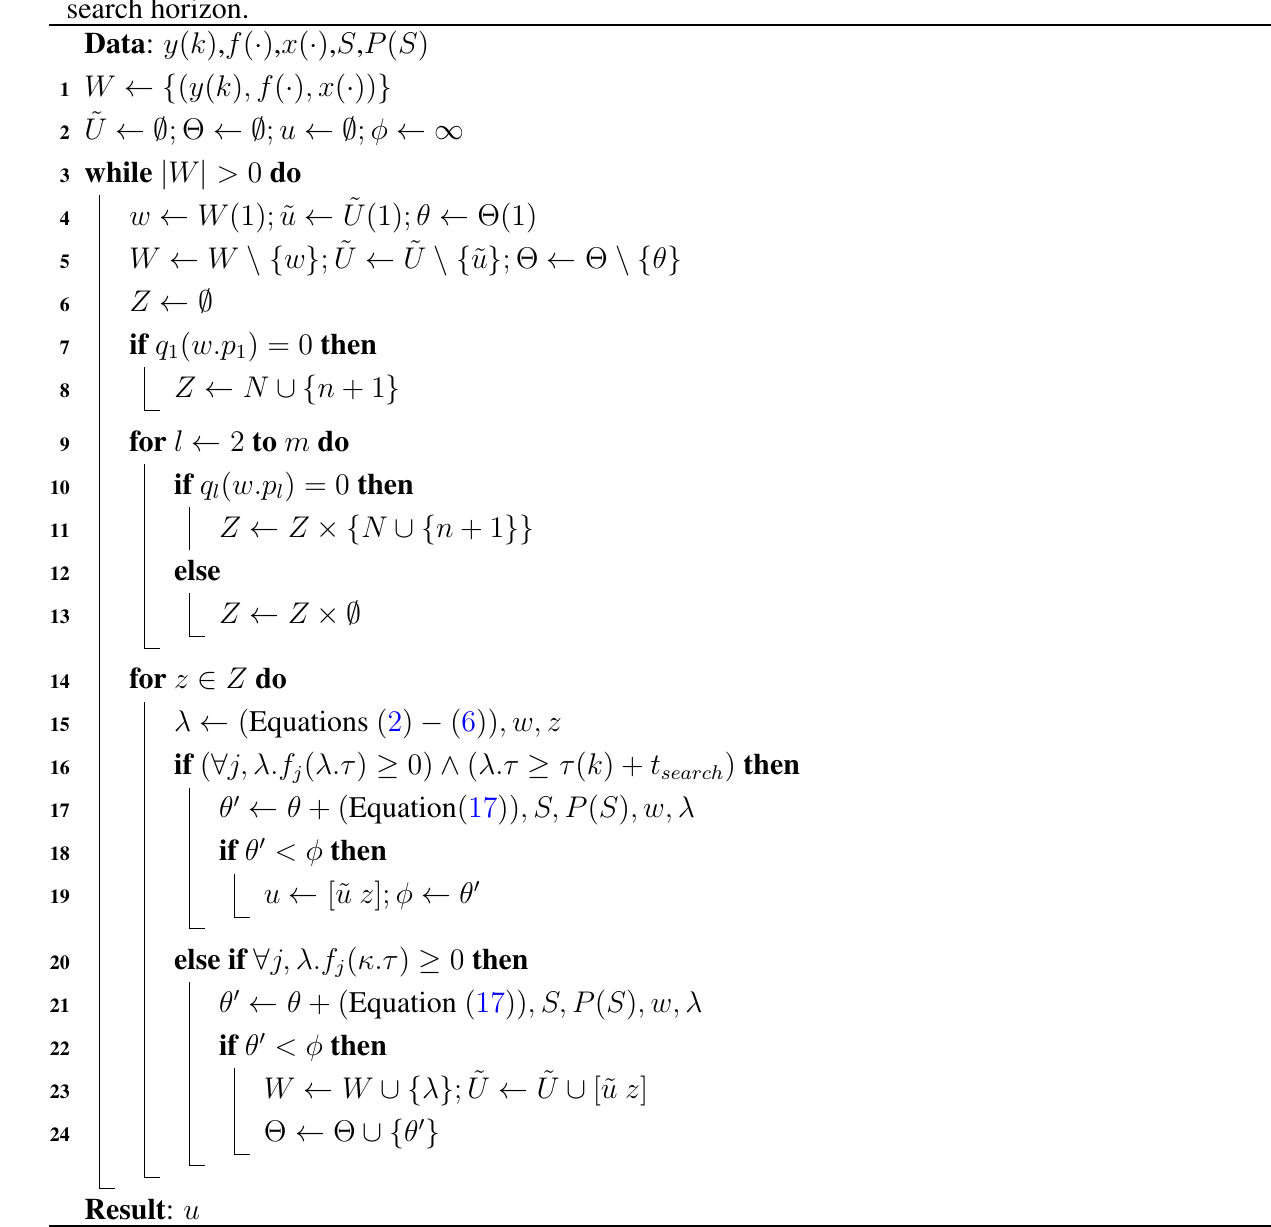
Algorithm 3: The uavsAction() heuristic to find the minimal cost action for the UAVs within a given search